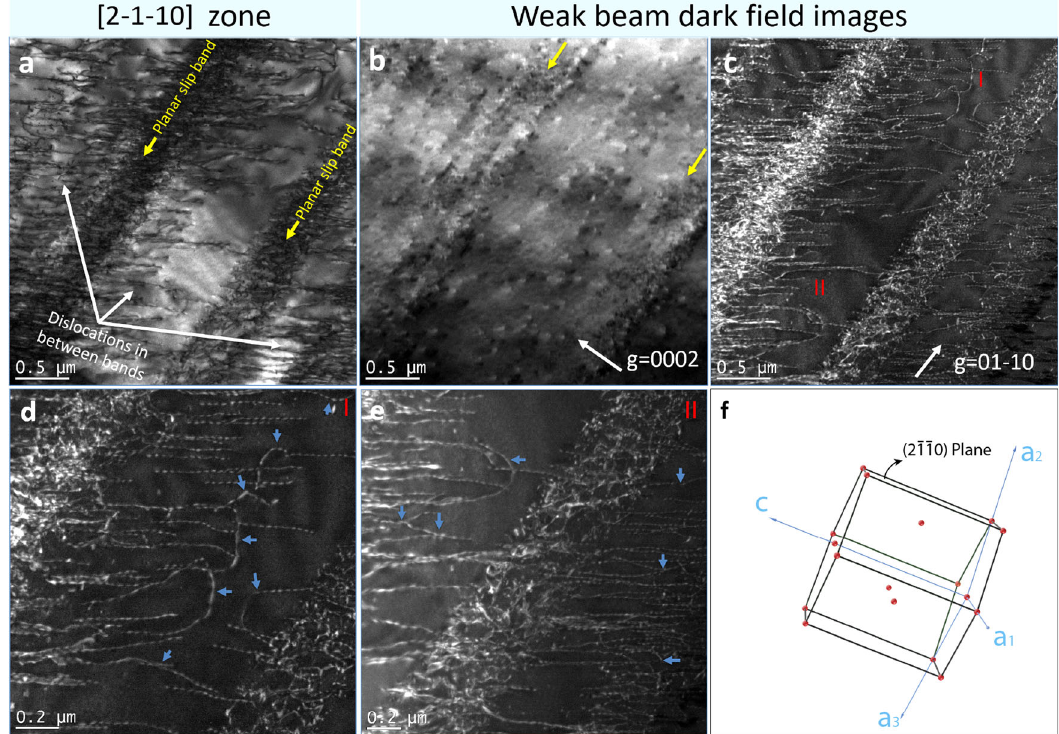
Fig. 4 Detailed analysis of dislocation morphologies in Ti-6Al-0.1 O after tensile deformation to 6.0% strain at cryogenic temperature. a Two planar slip bands and some scatteredly distributed dislocations in between the bands were observed from the zone axis of [2 – 1 – 10]. b – e Weak beam dark fi eld (WBDF) images of the same area. b Both planar slip bands and dislocations in between the bands disappeared when g = 0002, which excluded the existence of < c + a > dislo c ations. c WBDF image using g = 01 – 10, highlighted the dislocation loops nucleated from the slip bands, as well as the frequent occurrence of possible dislocation cross-slips in between the bands. Some typical examples (areas I and II) were indicated by blue arrows in d and e . A schematic of the crystallographic orientation for the imaging direction is given in f